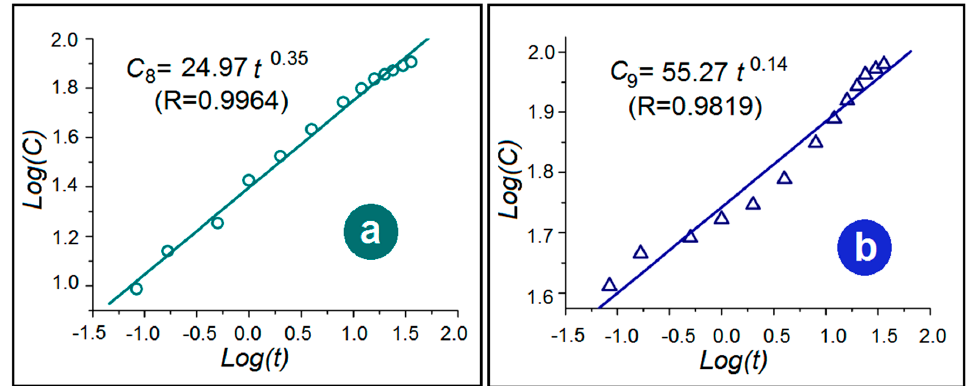
Figure 9. The drug release kinetics from the films of F8 ( a ) and F9 ( b ).